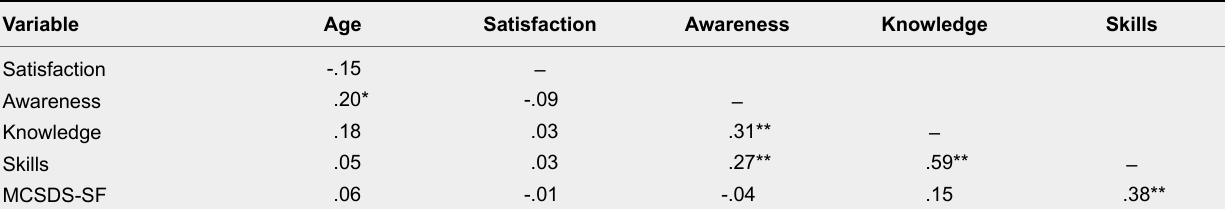
Means and Standard Deviations for Variables (n = 106) Variable